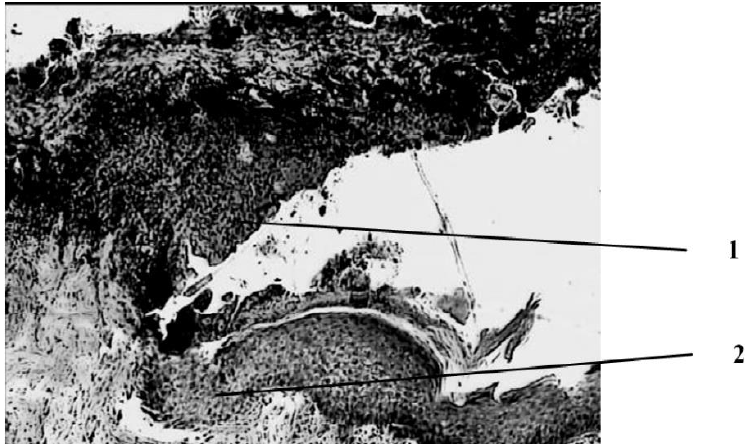
Figure 2. Morphological changes in the wound seven days after the application of the burn and subsequent treatment with Levomecol ointment. Initial manifestations of marginal epithelializa- tion. 1 — scab; 2 — regenerating epidermis with signs of regeneration (beginning of marginal epi- thelization). Staining with hematoxylin and eosin. magn. ×50.